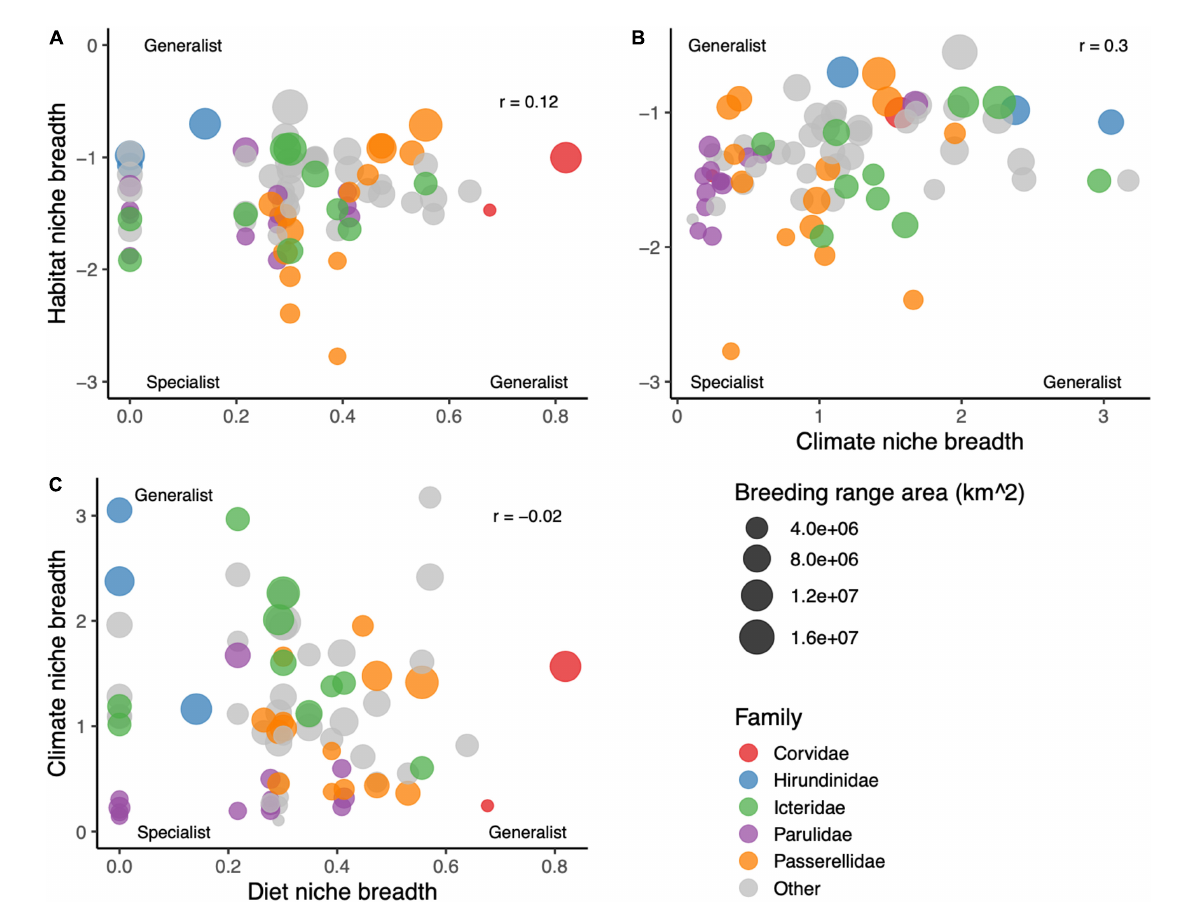
FIGURE2 Cross-correlations among the three measures of species niche breadth: (A) habitat versus diet niche breadth, (B) habitat versus climate niche breadth, and (C) climate versus diet niche breadth. Each species’ dot is sized by the breeding range area of the species, and colored by family.